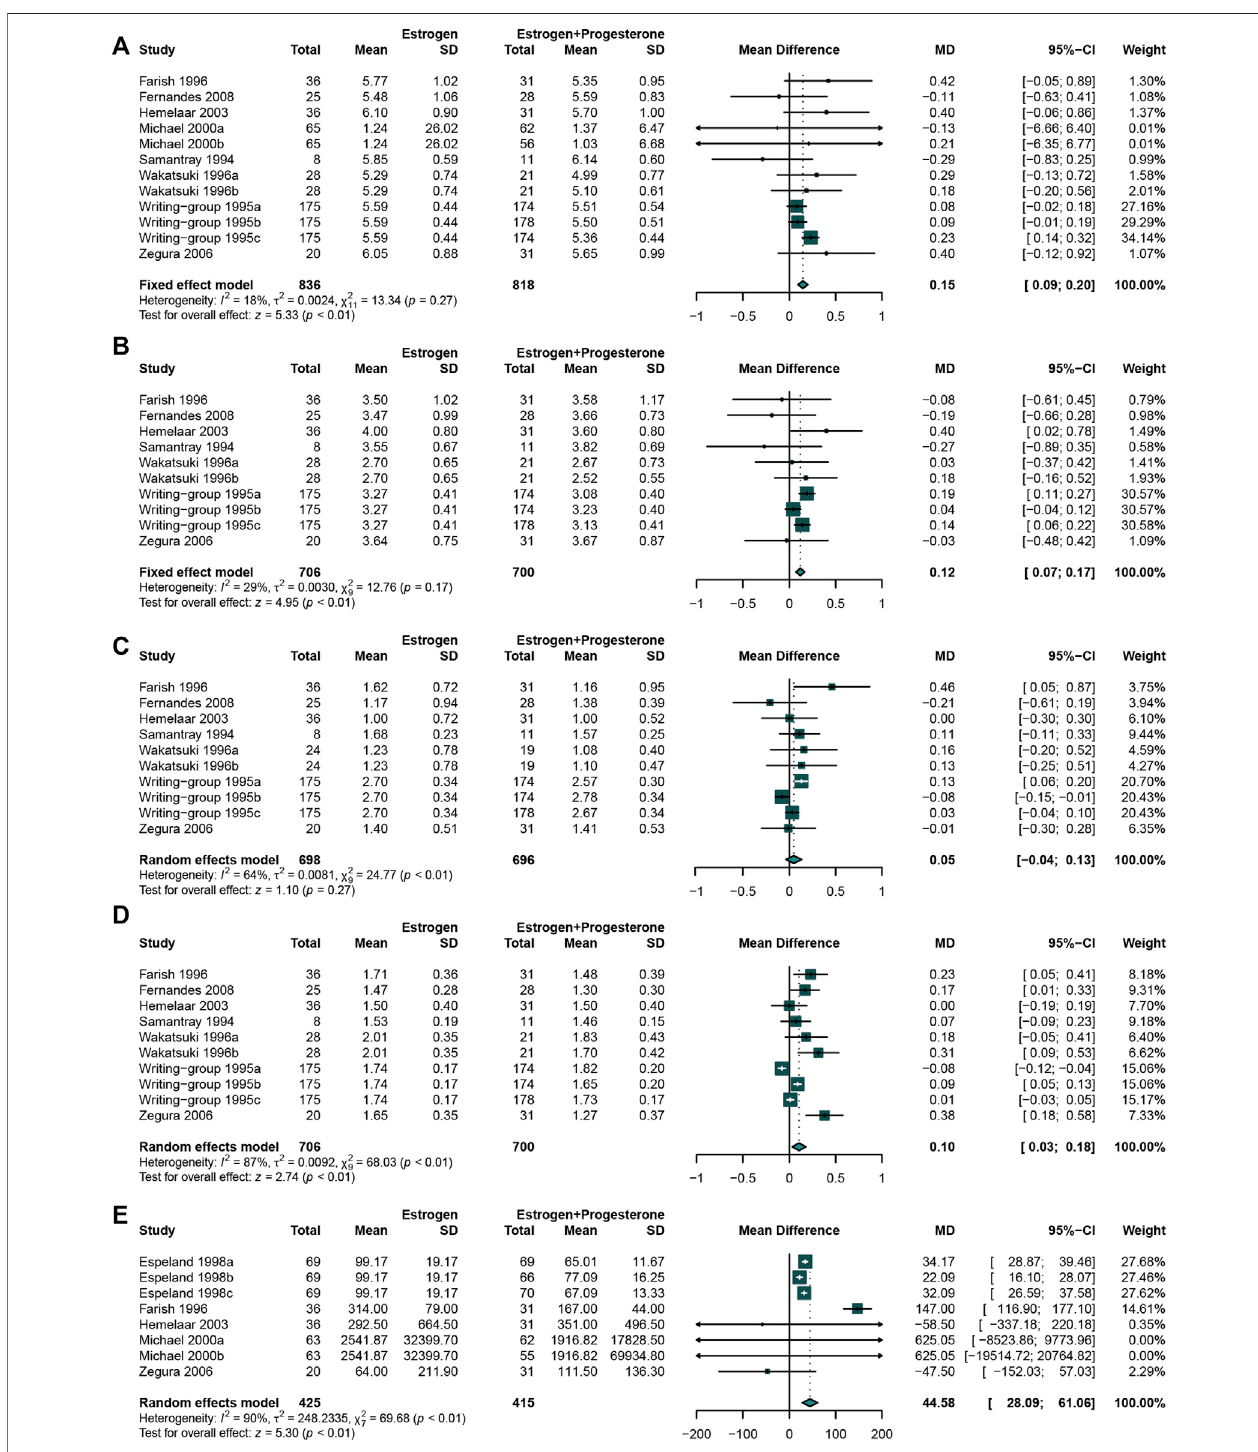
FIGURE8| Studiescomparingestrogenalonewithestrogenplusprogestogenregimen.Theestrogenplusprogestogenregimencouldsigni fi cantlyincreasedTC, LDL-C, HDL-C, and Lp(a) concentration compared with estrogen alone. (A) TC concentration; (B) LDL-C concentration; (C) TG concentration; (D) HDL-C concentration; (E) Lp(a)